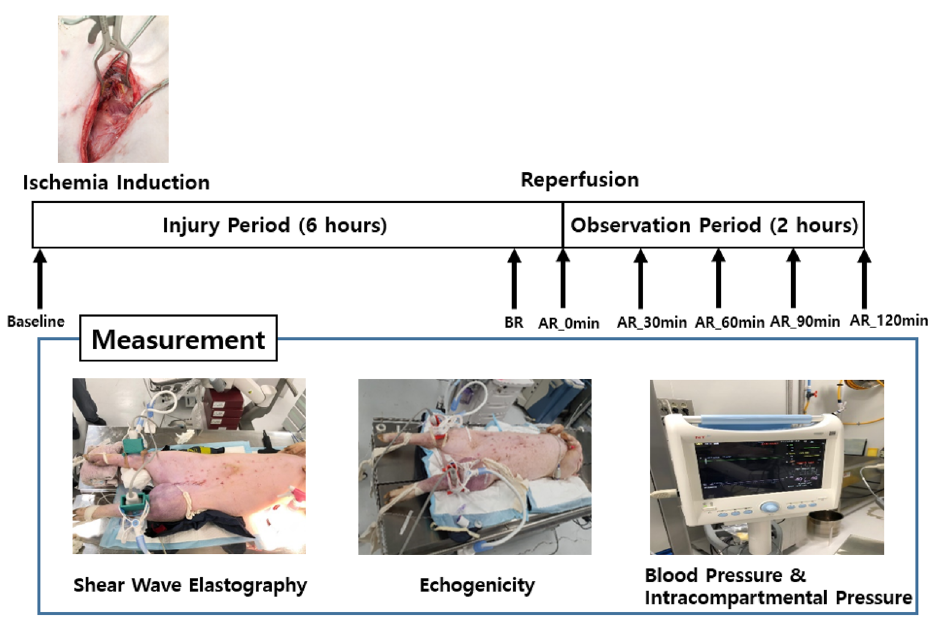
Figure 7. Experimental setup and